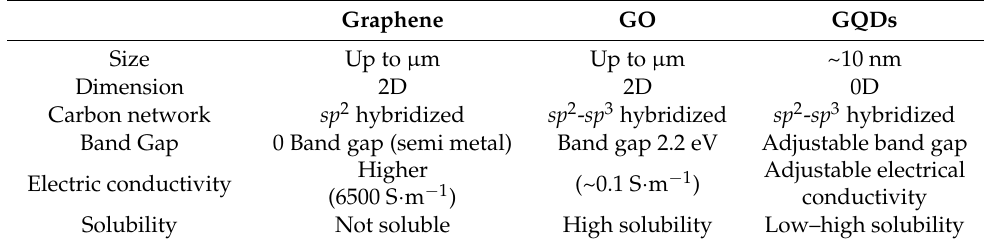
Table 1. Properties of Graphene, GO and GQDs.